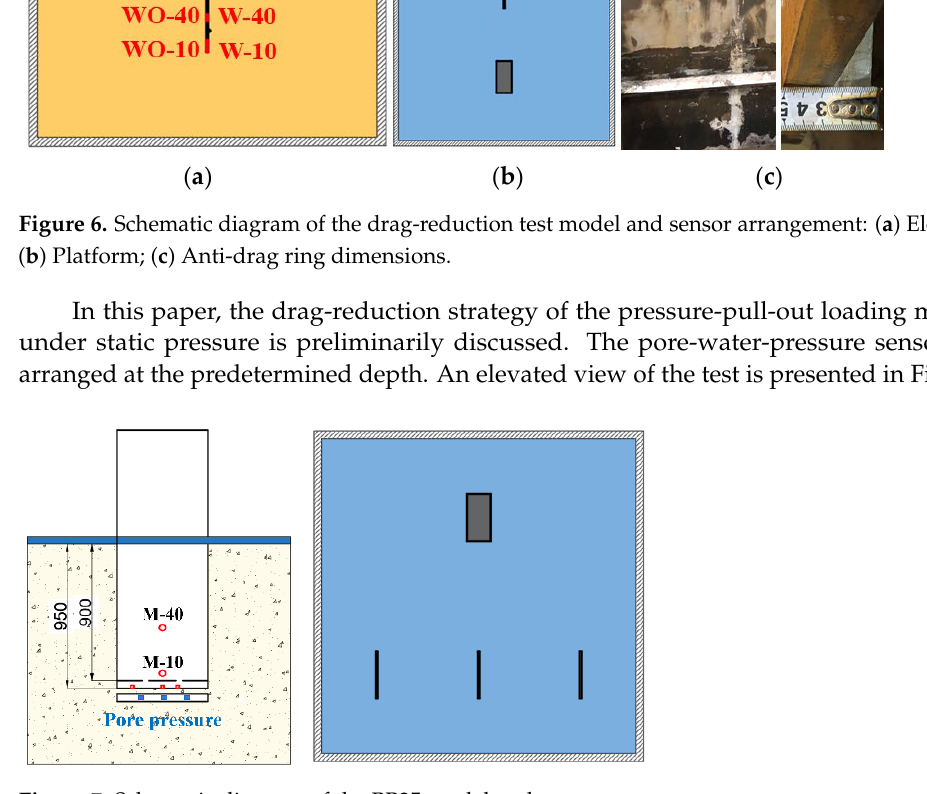
Figure 6. Schematic diagram of the drag-reduction test model and sensor arrangement: ( a ) Elevation; ( b ) Platform; ( c ) Anti-drag ring dimensions.